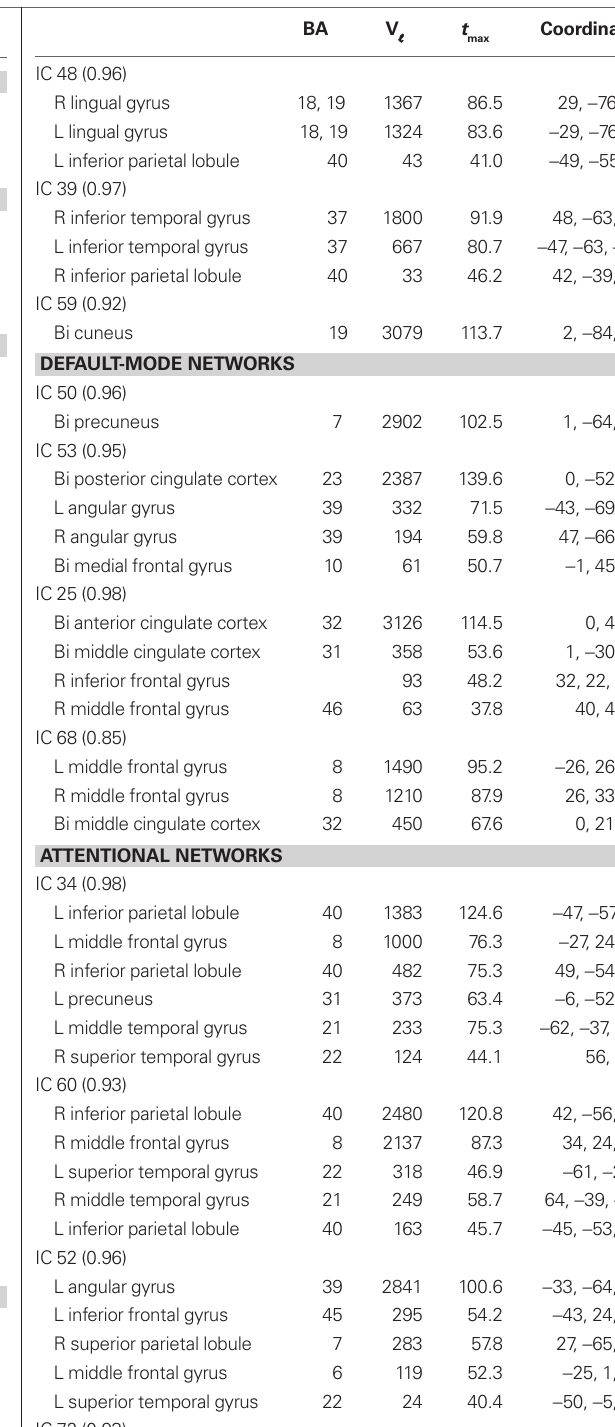
in MNI space, following max